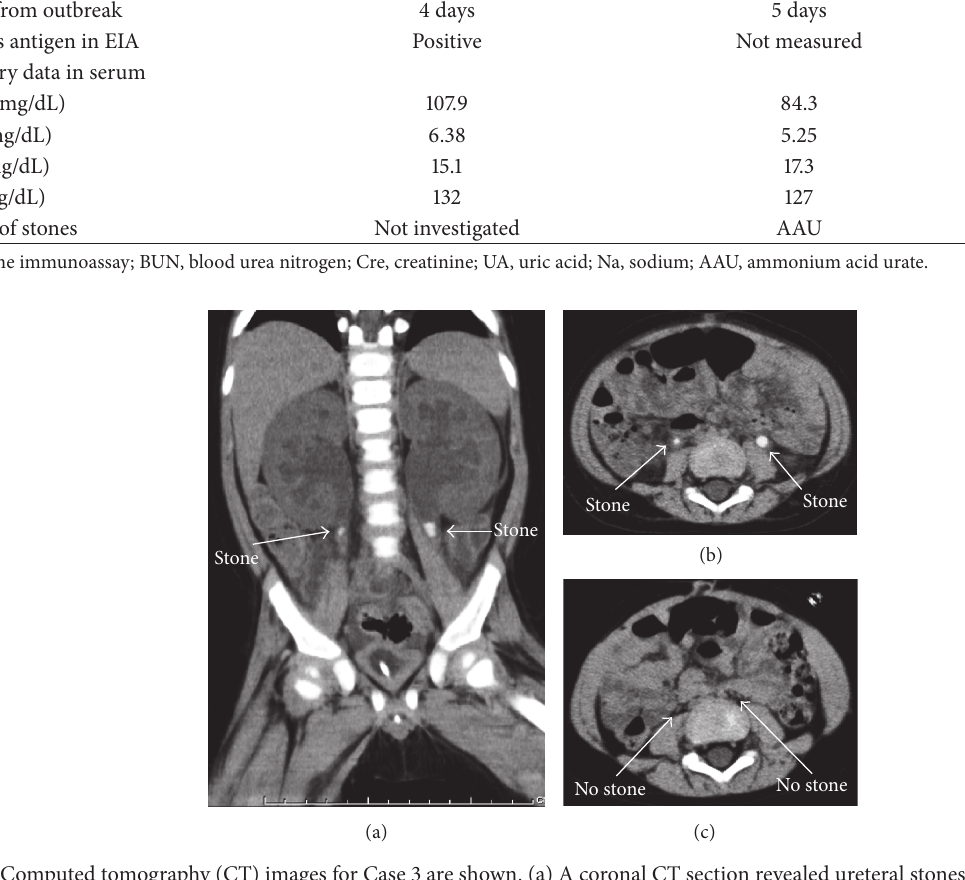
Figure 1: Computed tomography (CT) images for Case 3 are shown. (a) A coronal CT section revealed ureteral stones with hydronephrosis in the bilateral ureters (arrows). (b) A transverse CT section revealed ureteral stones with hydronephrosis in the bilateral ureters